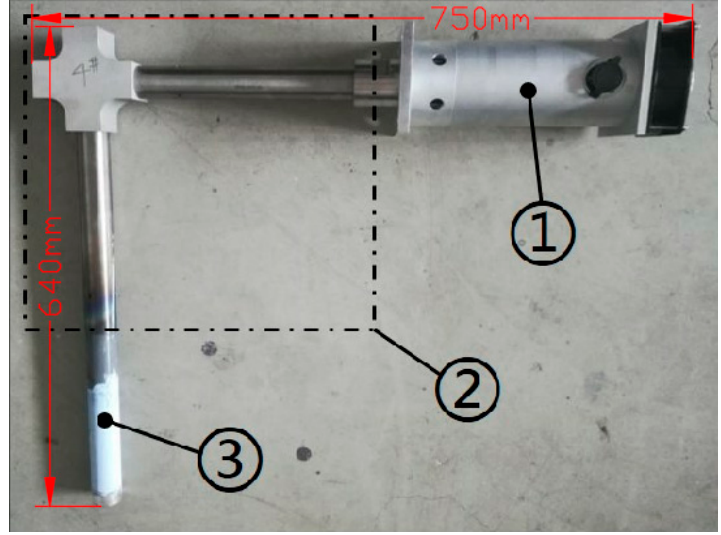
Figure 1. Structure of ultrasonic guided wave device.